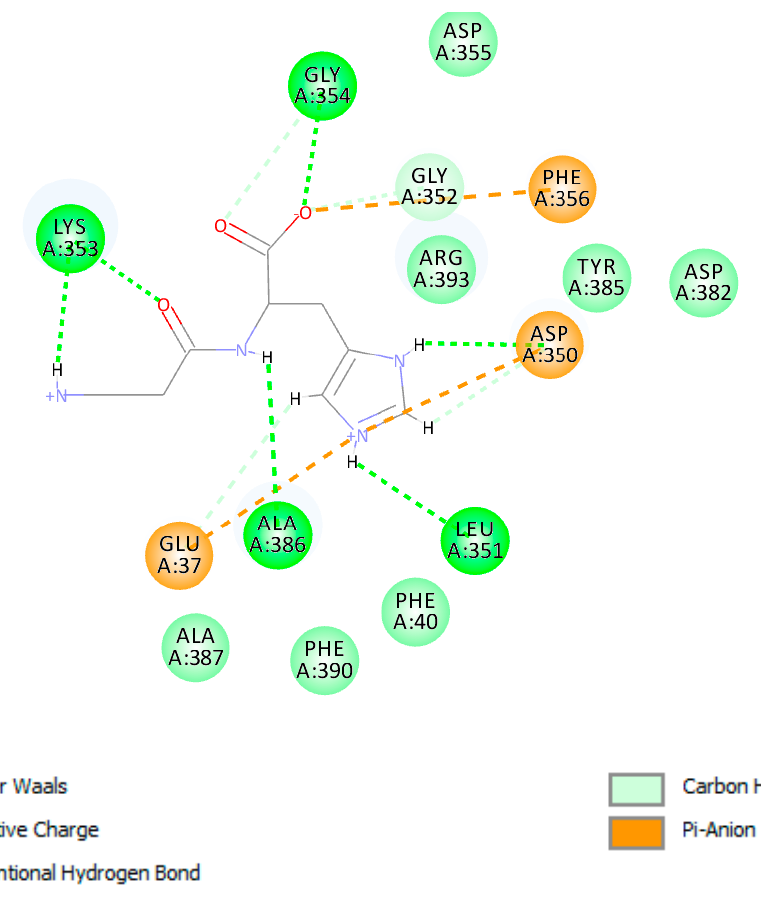
Figure 8. 2D diagram shows the docked pose of the highest score carnosine within the surface of ACE2 at site 3.